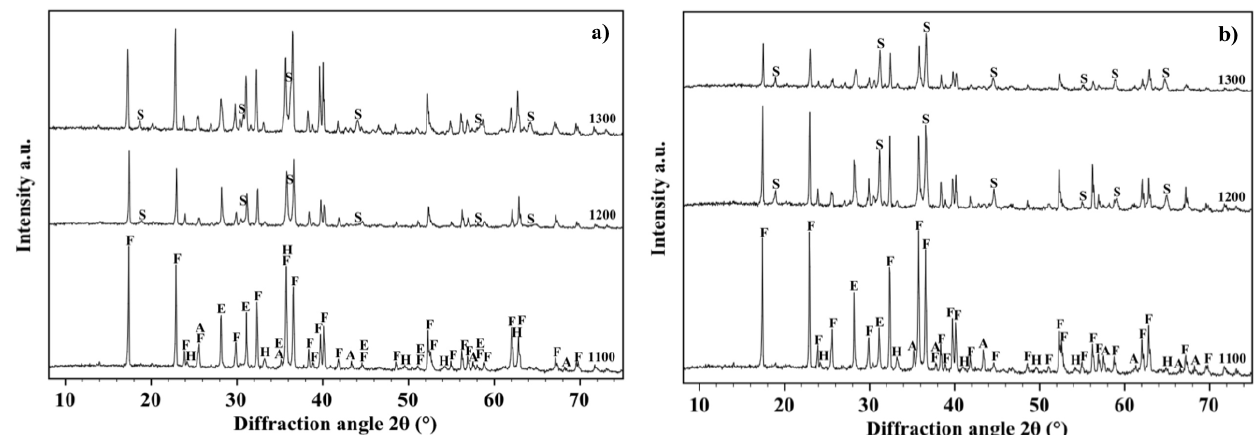
Figure 6. X-ray diffraction patterns between 10° and 70° acquired on the free surface of samples OA5 ( a ) and OA10 ( b ) fired at 1100, 1200 and 1300 °C. Phases are identified by the following symbols: (E) = enstatite, (F) = forsterite, (H) = hematite, (A) = alumina and (S) = spinel.